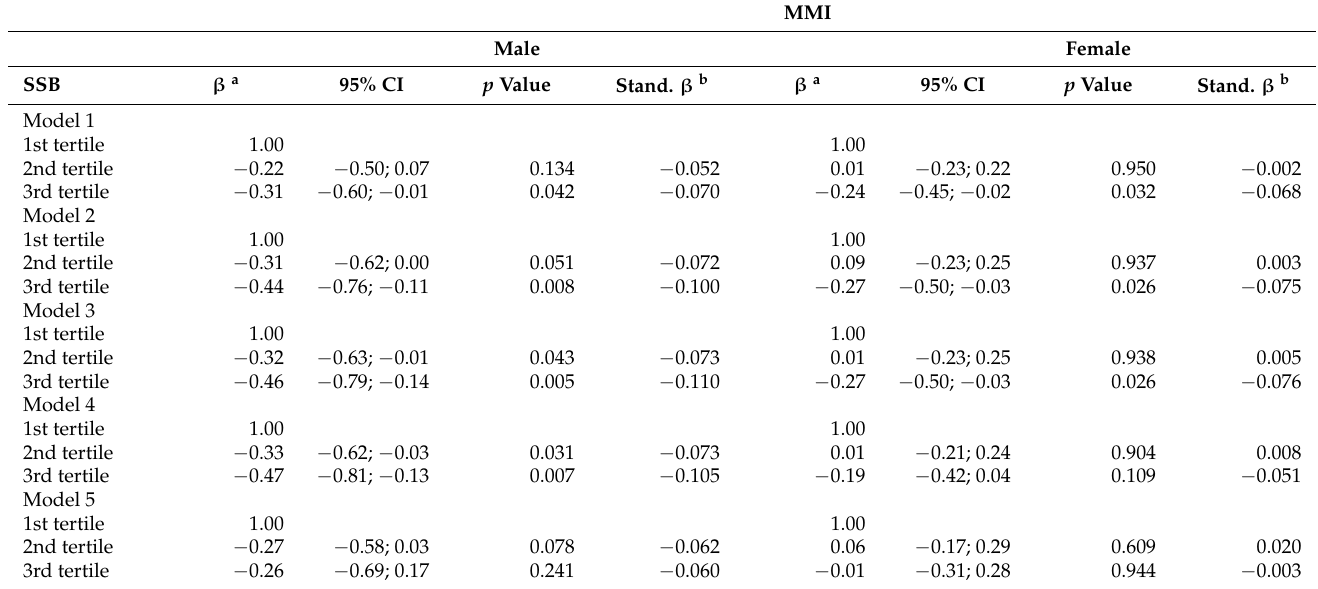
Table 3. Association between the frequency of daily consumption of sugar-sweetened beverages and muscle mass index in adolescents according to sex. Sao Luis, Brazil, 2016.